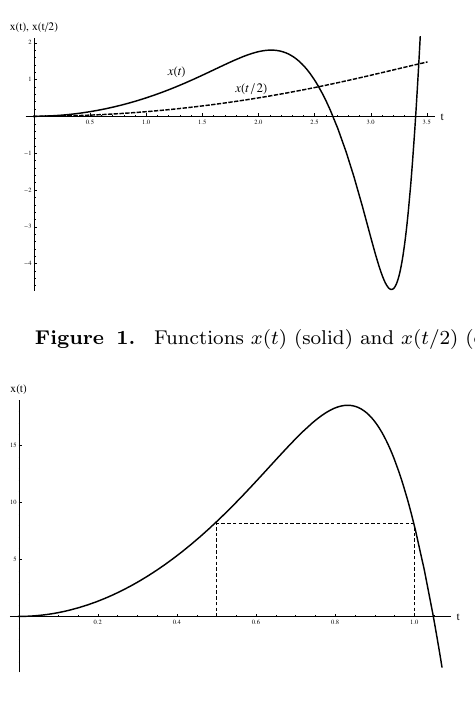
Figure 2. Solution x 1 ( t ) of problem